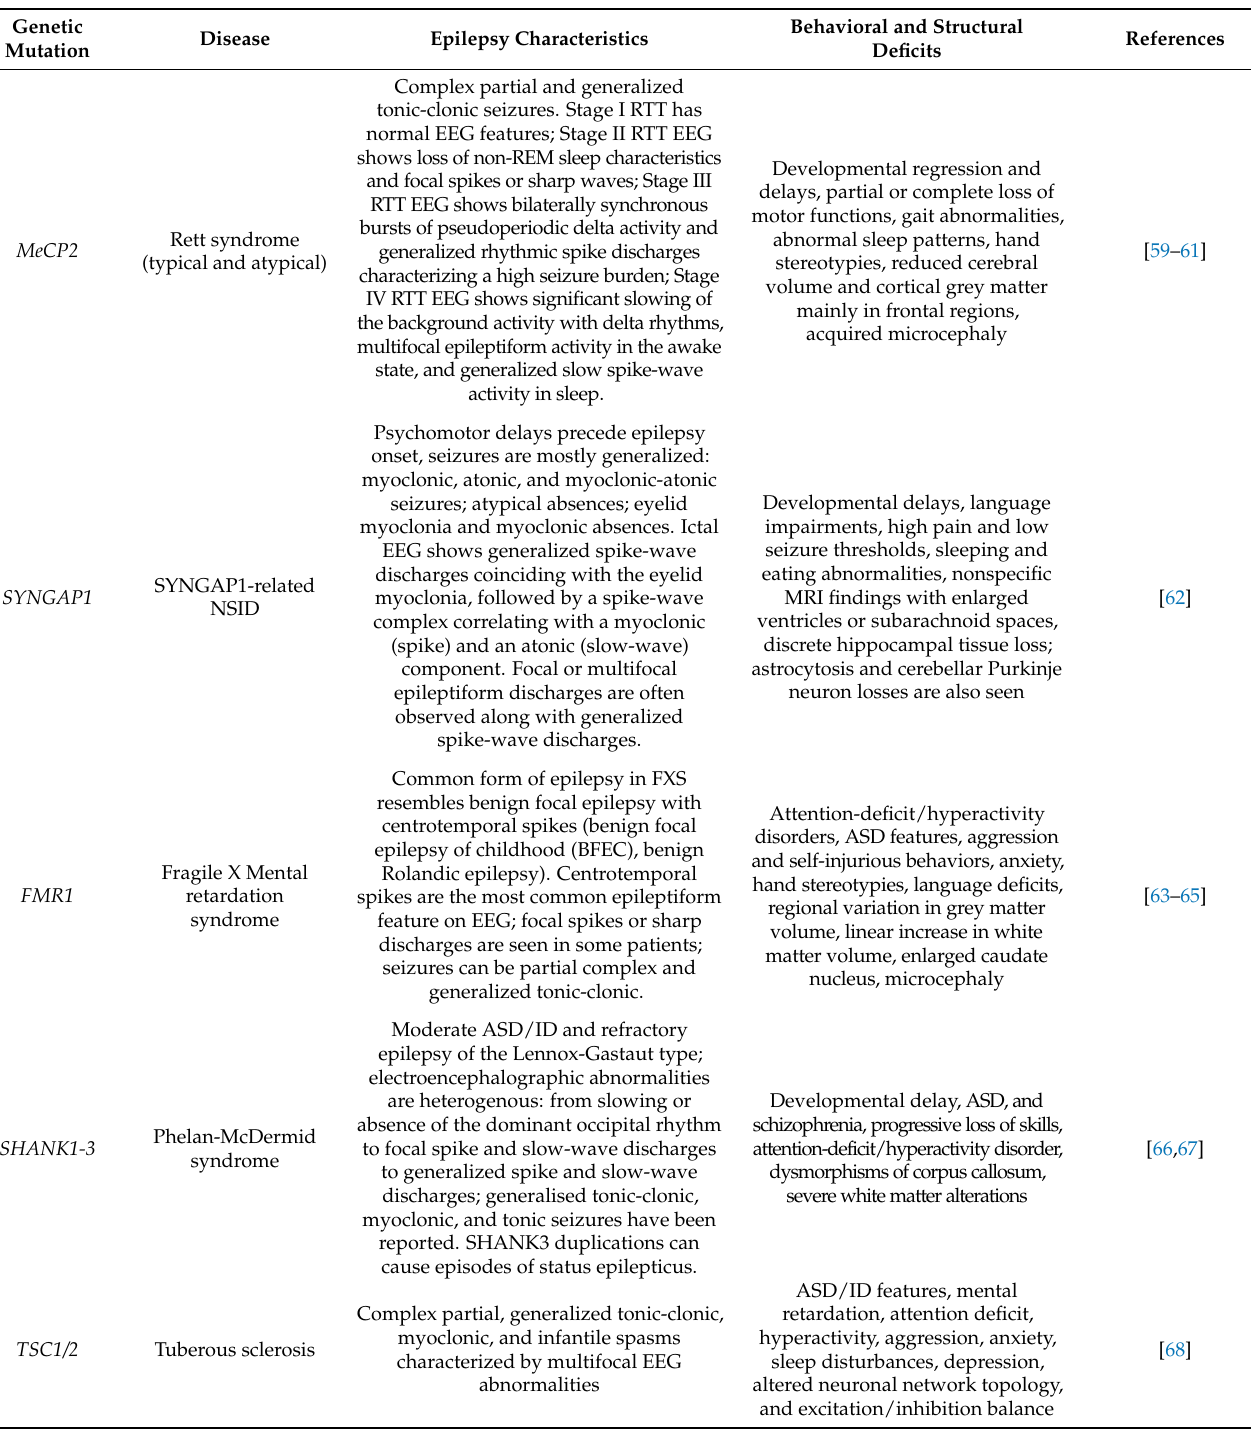
Table 1. Tabulation of epilepsy characteristics and behavioral and structural deficits in different NDD-related genes from human patient data (FMR1, SYNGAP1, SHANK, TSC, and